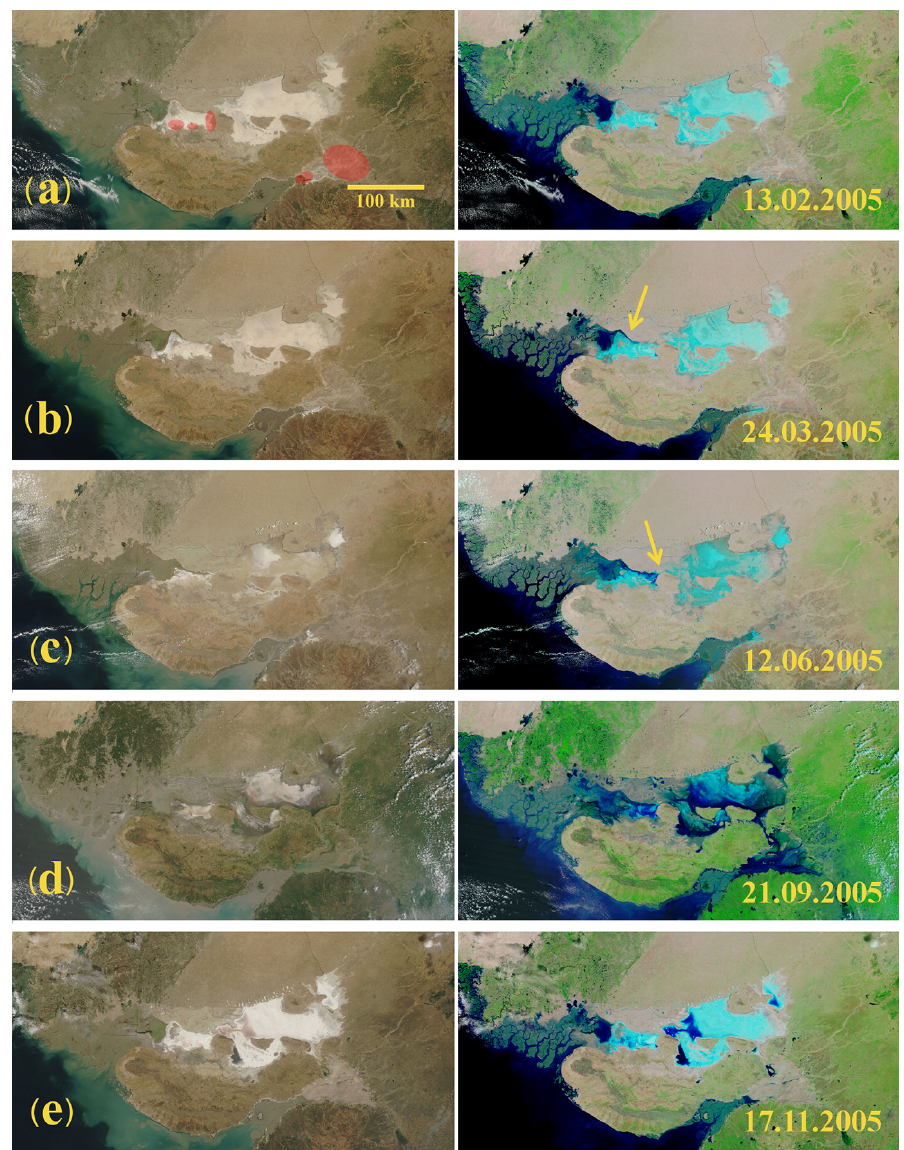
Figure 2. MODIS True Color (TC, left) and Band 7-2-1 images (right) over the Rann of Kutch for selected days in (a) February, (b) March, (c) June, (d) September and (e) November 2005 (13.2., 24.3. 12.6., 21.9. and 17.11.), illustrating the flood during the monsoon. Water can be identified from the 7-2-1 images as dark blue/black, while clouds and bright surfaces appear light blue. The Rann appears as a bright surface earlier in the year, before it darkens due to inflowing water (indicated by yellow arrows in (b) and (c) , right column; compare with the mean reflectivity shown in Fig. 4). During monsoon time, the entire Rann is often completely flooded and large areas are dominated by mud (TC image in September). Locations of industrial evaporation ponds are indicated by areas marked in red in (a)